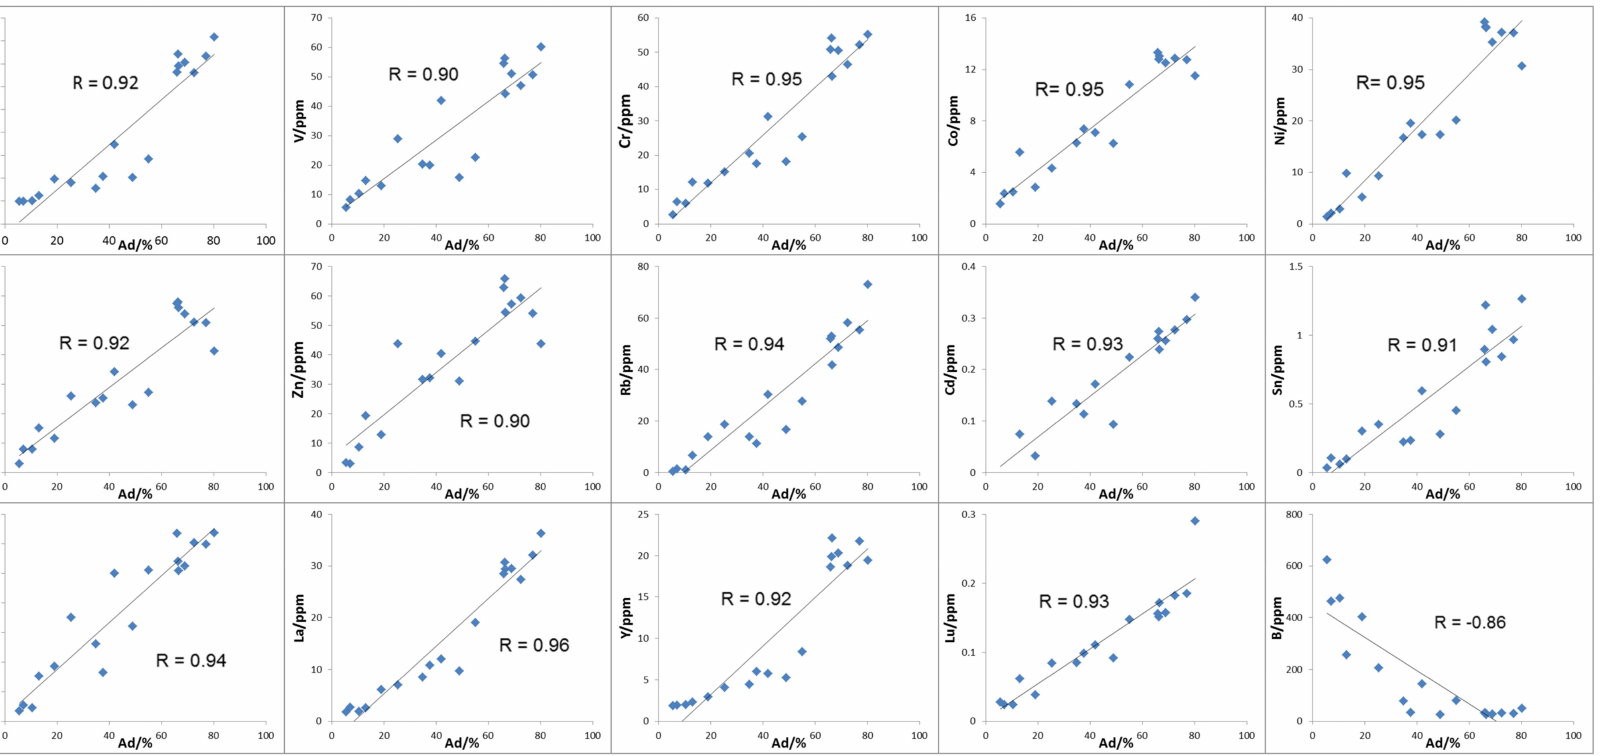
Figure A1. Relations between Sc, V, Cr, Co, Ni, Cu, Zn, Rb, Cd, Sn, Cs, La, Y, Lu and B with ash yields in the coal and oil shale samples of the Liangjia Coal Mine, Huangxian